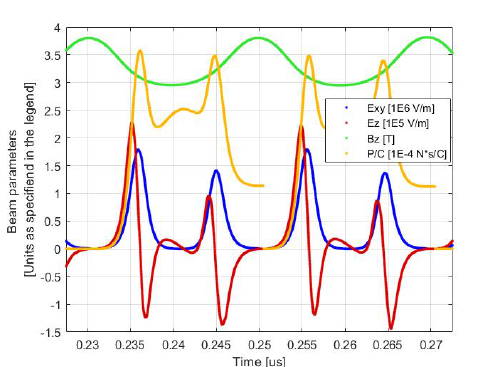
Figure 13. Details of electric field components and transverse momentum provided to the beam for two consecutive RF